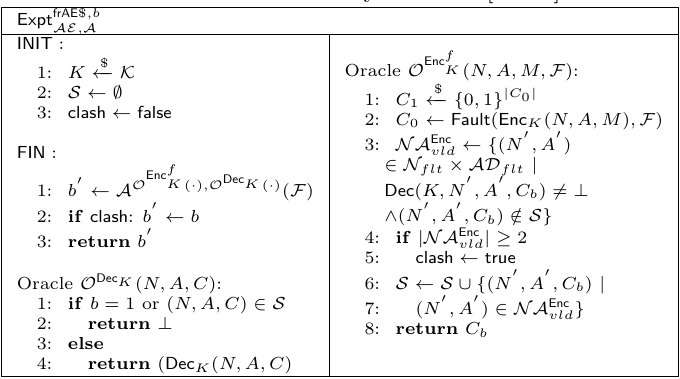
Table 11: The Security Game in